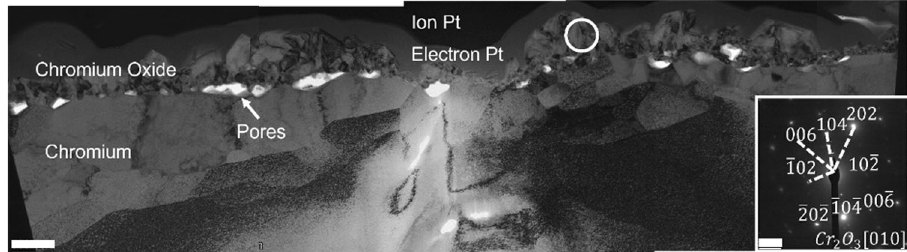
Fig. 1 TEM bright fi eld micrograph of chromium sample oxidized in air for 24 h at 700 °C. The formation of chromium oxide (evident from selected area electron diffraction pattern) is shown as well as pores (bright white contrast) which are mostly found at the metal/oxide interface. Scale bar for TEM: 500 nm. Scale bar for SAED: 2 nm.